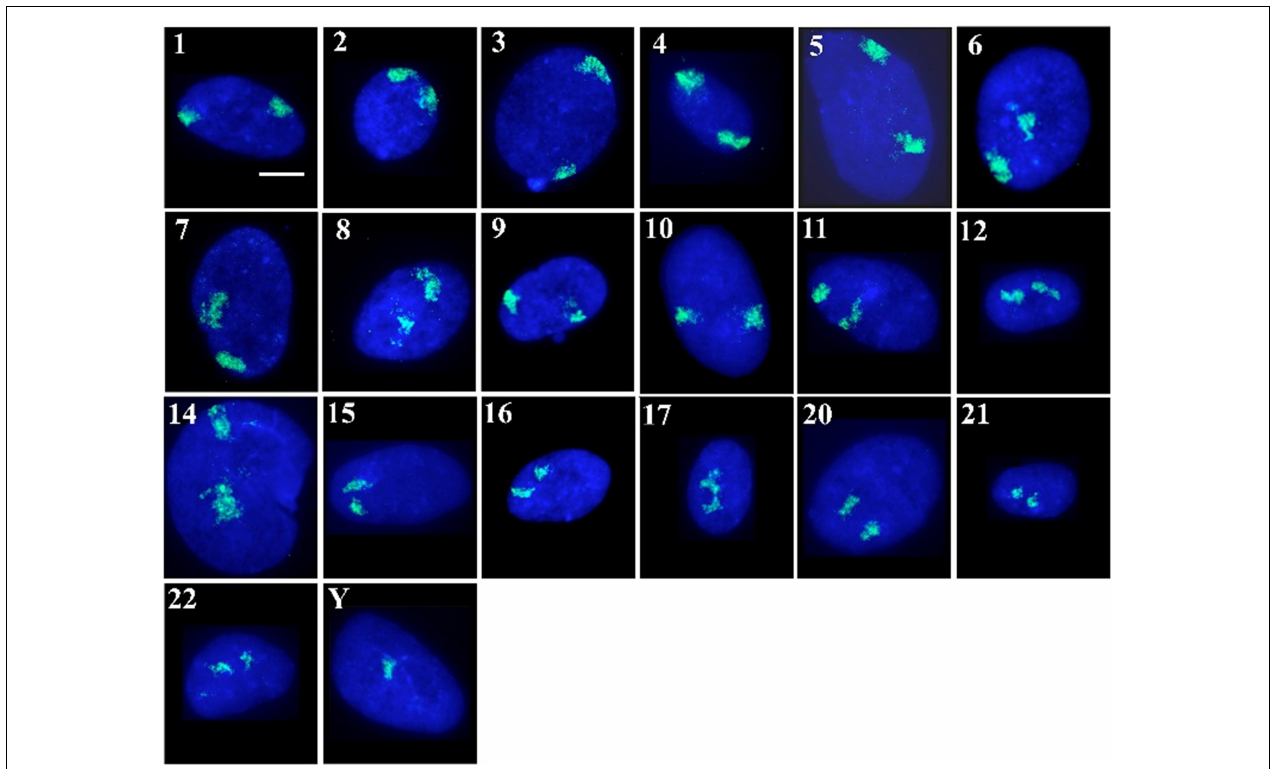
FIGURE 1 | Human chromosome territories in normal senescent human dermal fibroblast nuclei: Representative images displaying the spatial arrangement of human chromosome territories (in green) in senescent interphase nuclei of fibroblasts, stained with DAPI (blue). The numbers/letters by the side of each nucleus indicates the chromosome hybridised to by fluorescence in situ hybridisation. All the cells were grown in 10% new born calf serum and were found to be negative for the proliferation marker pKi-67. Scale bar = 10 µ